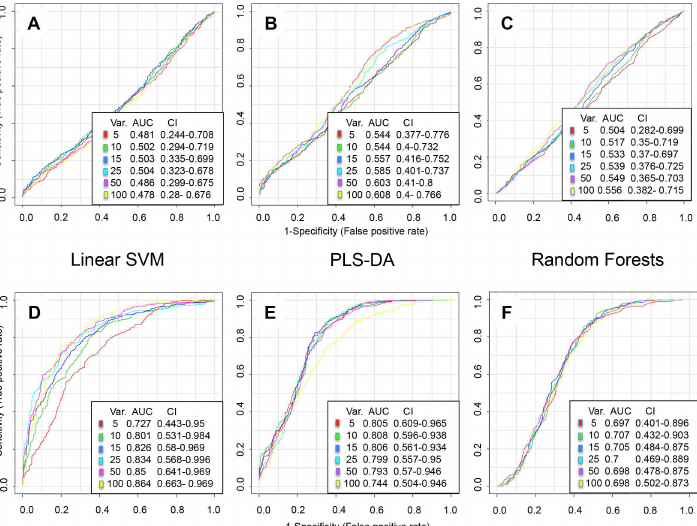
Fig 2. Athlete cohort preliminary multivariate ROC AUC analysis plots. Example college athlete cohort (Athletes) receiver operating characteristic (ROC) area under the curve (AUC) analysis results from the MetaboAnalyst 3.0 Explorer function of Biomarker Analysis module, with plots of sensitivity (y-axis) and 1-specificity (x-axis). In A-C , the plots indicate no significant difference between the CAC Preseason mild traumatic brain injury (mTBI) and non- concussed subjects (NCS) groups using either (i) Linear support vector machine (SVM), (ii) partial least squares discriminant analysis (PLS-DA), or (iii) random forests methods. ROC AUC values in all three analyses are ~ 0.5. The legend at lower right of each graph indicates AUC and 95% confidence interval (CI) values for derived models using 5–100 analytes (Var.). Plots D-F provide examples of more significant differences between comparison groups, such as between Athlete Preseason NC (non-concussed teammate controls) and the Season NC groups, using the same analytic methods as A-C, but with ROC AUC results ranging from about 0.70 to 0.86.